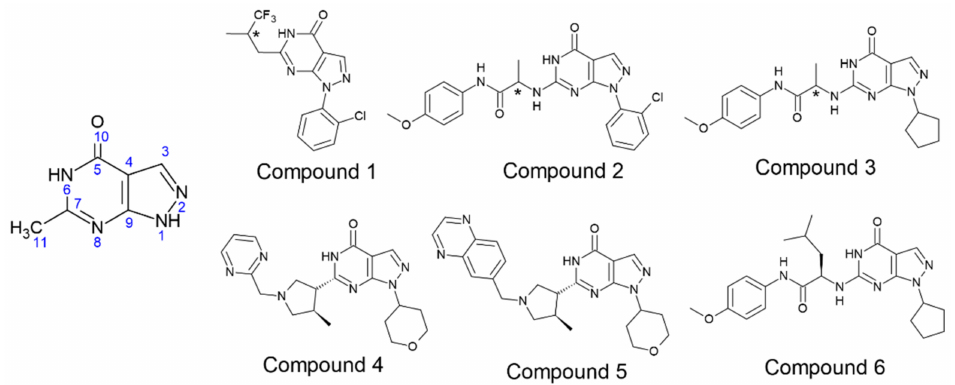
Figure 1. Selected literature reported chemical structures of PDE9 inhibitors [18]. Compound 1 (BAY73-6691), Compound 2 (28r and 28s), Compound 3 (3r and 3s), Compound 4 (PF-04447943), Compound 5 (PF-4181366), and Compound 6 (4r). The chiral carbon that makes two enantiomers were marked with symbol (*). Common substructure included separately with